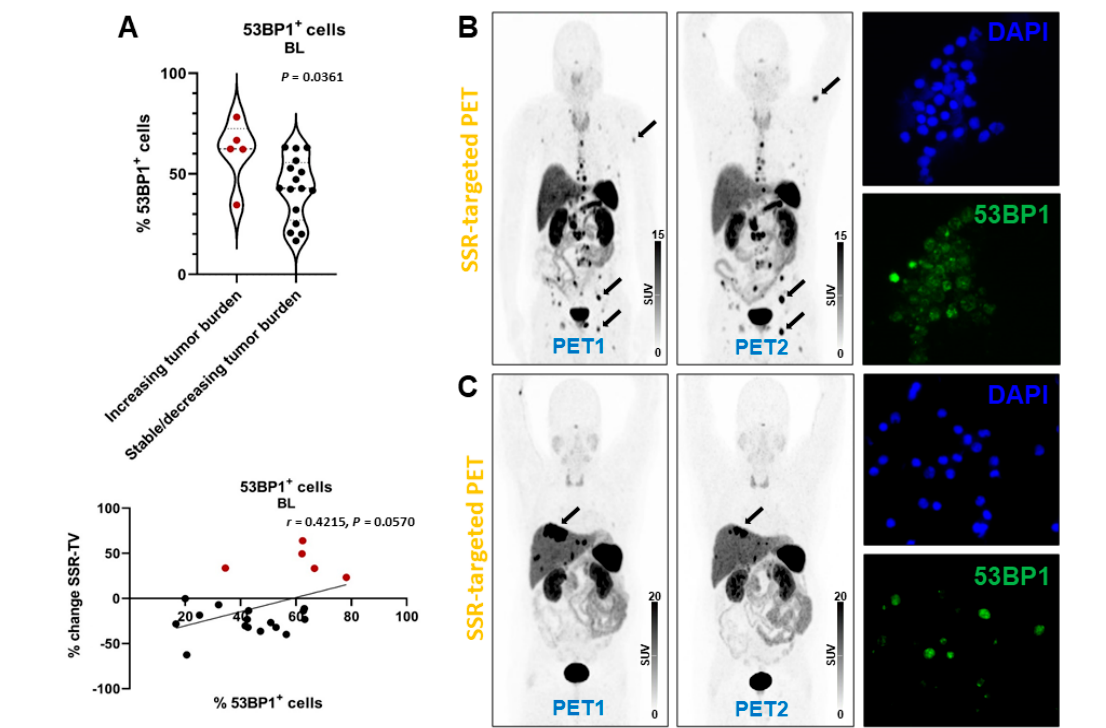
Figure 5. DNA damage response and post-therapeutic change in tumor burden in patients receiving PRRT. ( A ) Violin plot (upper panel) showing % 53BP1 + cells at baseline. Patients with stable or decreasing tumor burden had significantly less 53BP1 + cells. The change in tumor burden (SSR-TV) demonstrated a borderline significant correlation (lower panel) with the relative number of 53BP1 + cells at baseline. Red dots indicate increasing tumor burden. ( B ) Somatostatin receptor (SSR)-targeted maximum-intensity projection PET image before (PET1) and after (PET2) PRRT in a patient with increasing tumor burden (arrows indicate lesions with marked tumor volume increase). This patient had a comparably high relative number of 53BP1 + cells at baseline (right lower panel; DAPI nucleic acid staining for comparison, right upper panel). ( C ) Somatostatin receptor (SSR)-targeted maximum-intensity projection PET image before (PET1) and after (PET2) PRRT in a patient with decreasing tumor burden (arrow indicates lesion with marked tumor volume decrease). This patient had a comparably low relative number of 53BP1 + cells at baseline (right lower panel; DAPI nucleic acid staining for comparison, right upper panel) (63x/1.6).